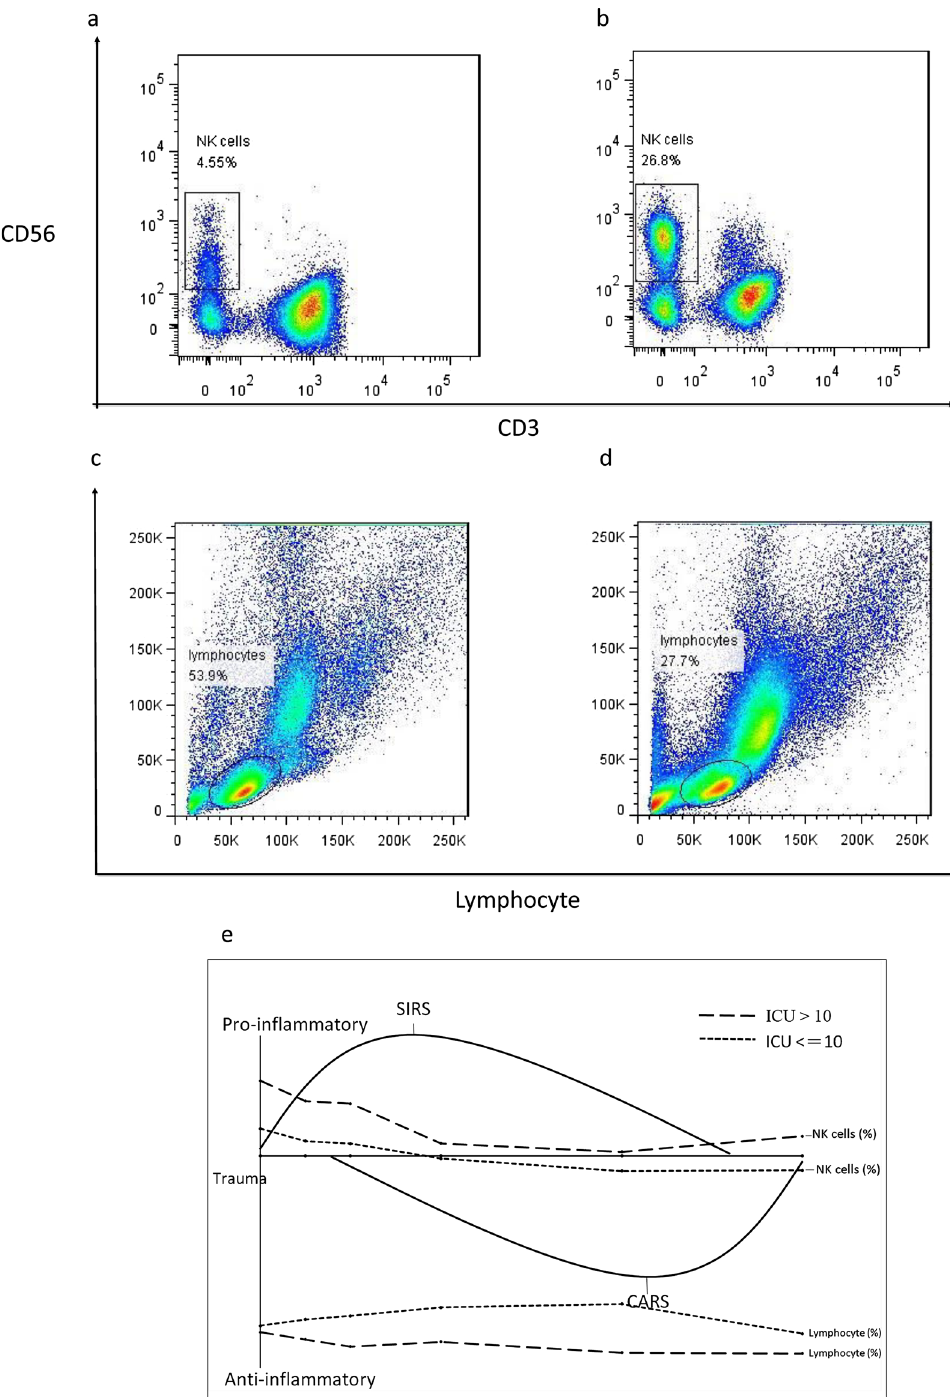
Figure 8. Trauma patients with long ICU stay had increased NK cells and lymphopenia compared to that with short ICU stay. ( a,c ) NK cells and lymphocytes in patient with short ICU stay. ( b,d ) NK cells and lymphocytes in patient with long ICU stay. ( e ) The SIRS, CARS and dynamics of immunity in trauma